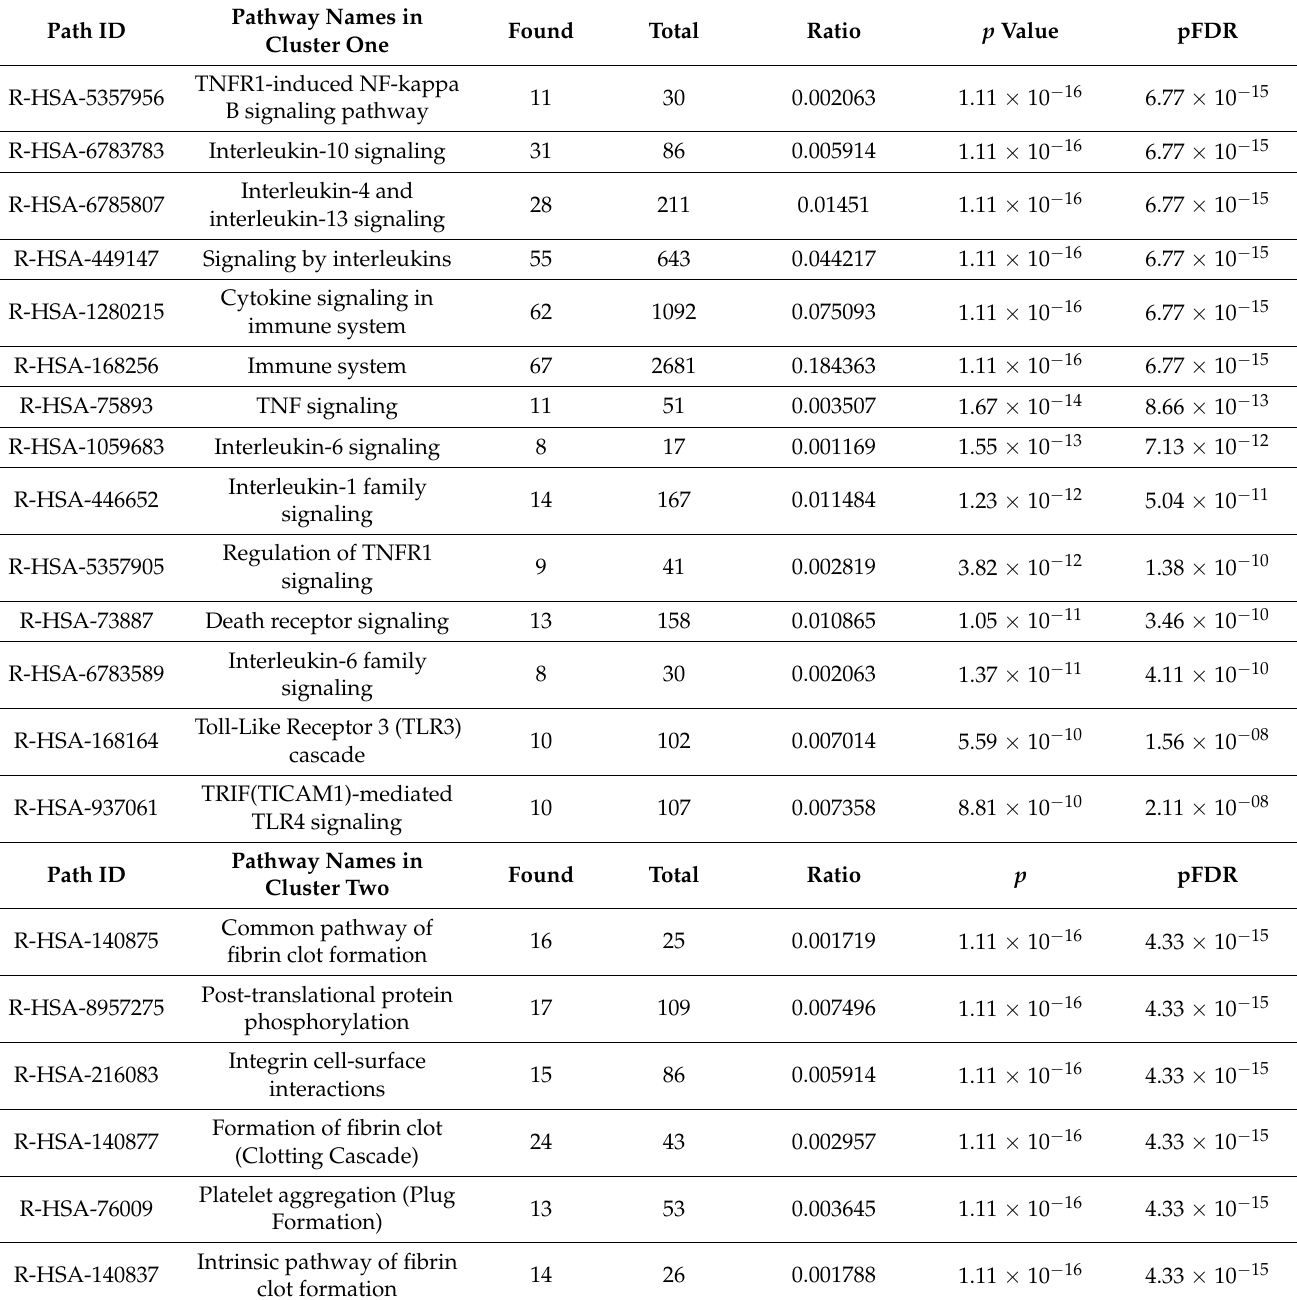
Table 2. REACTOME path classifications of the differently expressed proteins in cluster one of death due to